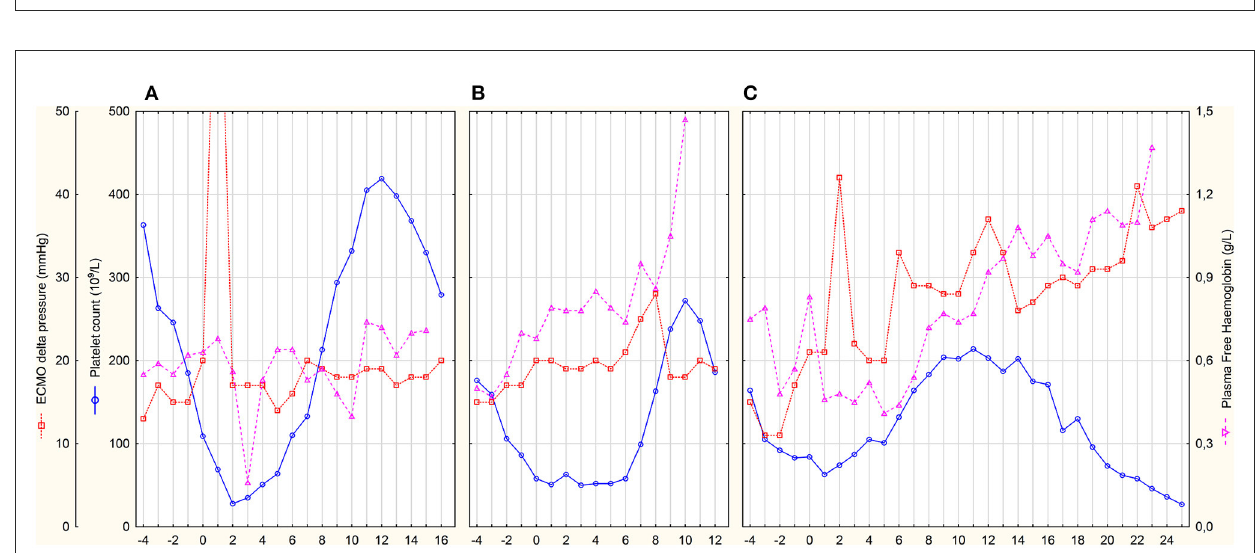
FIGURE2 Daily platelet count and markers of ECMO circuit thrombosis. x-axis represents days after HIT diagnosis and commencement of fondaparinux treatment. (A–C) represent individual